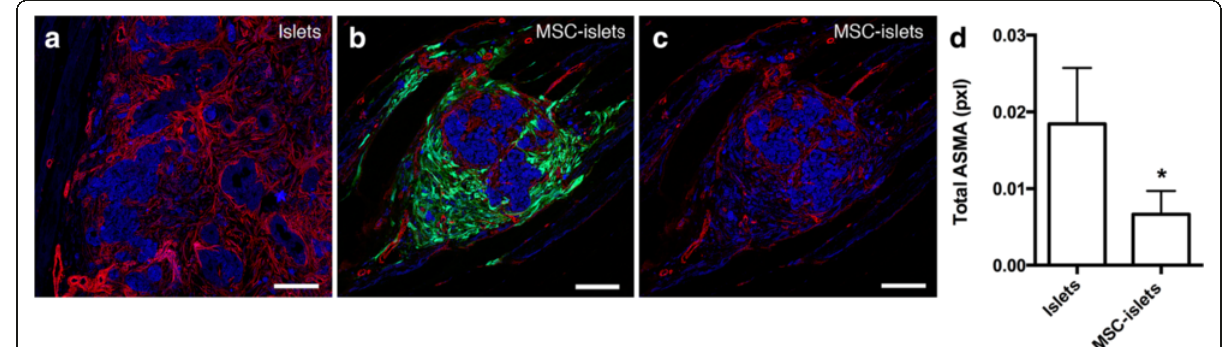
Fig. 4 Fibrotic encapsulation of the grafted islets visualized by α SMA expressing tissue one week post transplantation. a Control section with a large portion of α SMA + (red) fibrotic tissue surrounding the islets (blue). b In the presence of MSC (green) one-week post transplantation only a moderate fibrotic encapsulation ( α SMA, red) could be seen surrounding the islets (blue). c Tissue in panel B without imaged MSC. d Quantification showed significantly lower levels (* p < 0.05) of fibrotic tissue surrounding the graft at 7 days post transplantation in the pres- ence of MSC as measured by total expression of α SMA. Bars = 100